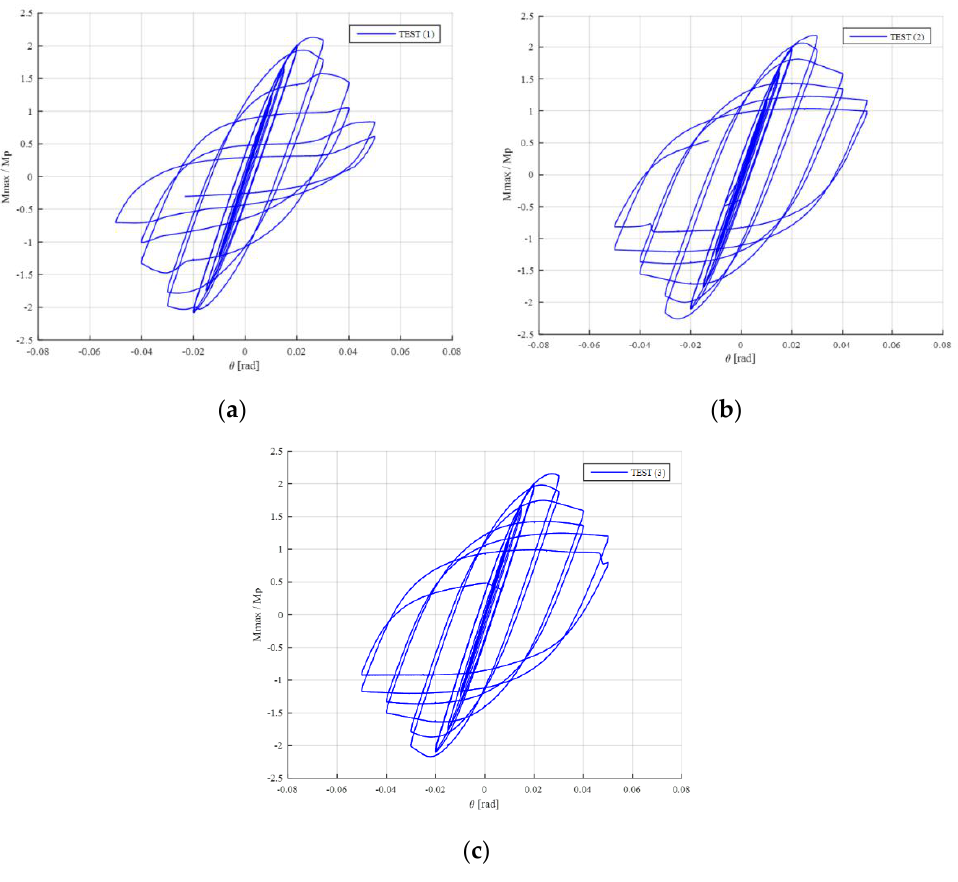
Figure 6. Normalized moment rotation hysteresis curves: ( a ) test 1, ( b ) test 2 and ( c ) test 3. Note: Mmax, is the maximum moment reached in the test and Mp, is the plastic moment.